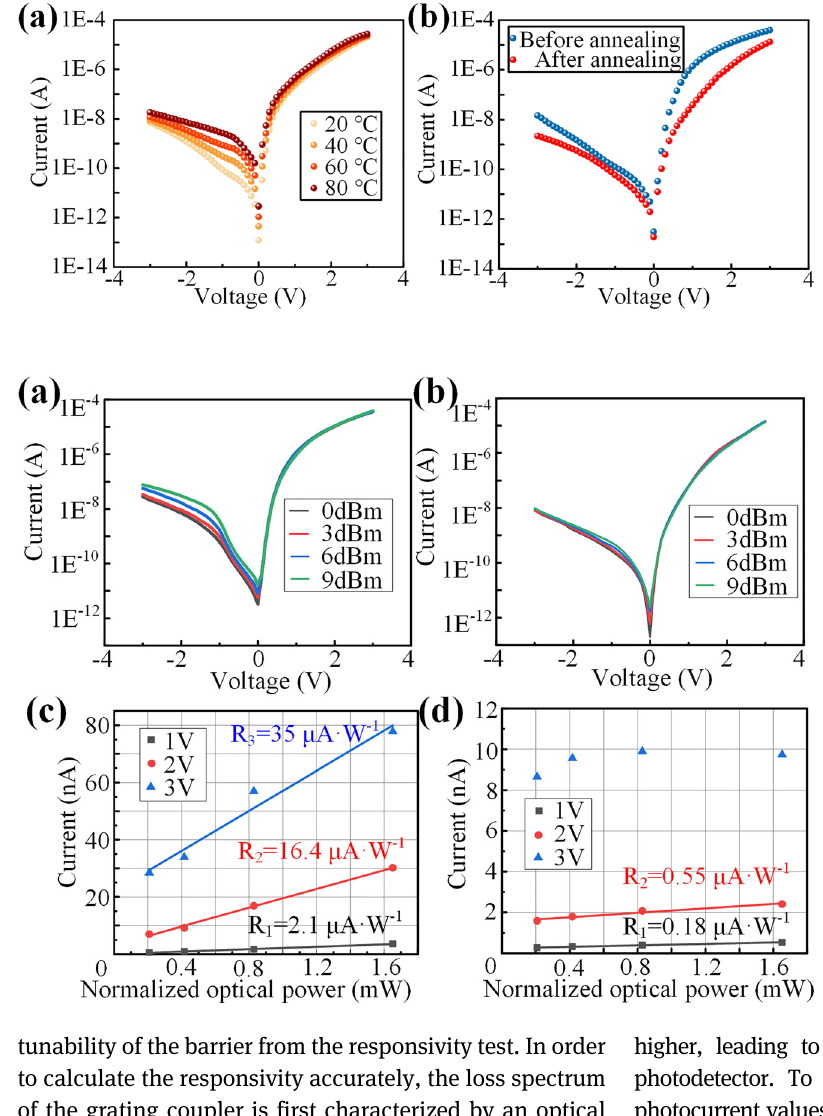
Figure 5: Current – voltage measurements under 1550 nm illumination (a) before and (b) after vacuum annealing. And photocurrent as a function of the optical power at different reversed biases (c) before and (d) after vacuum annealing.